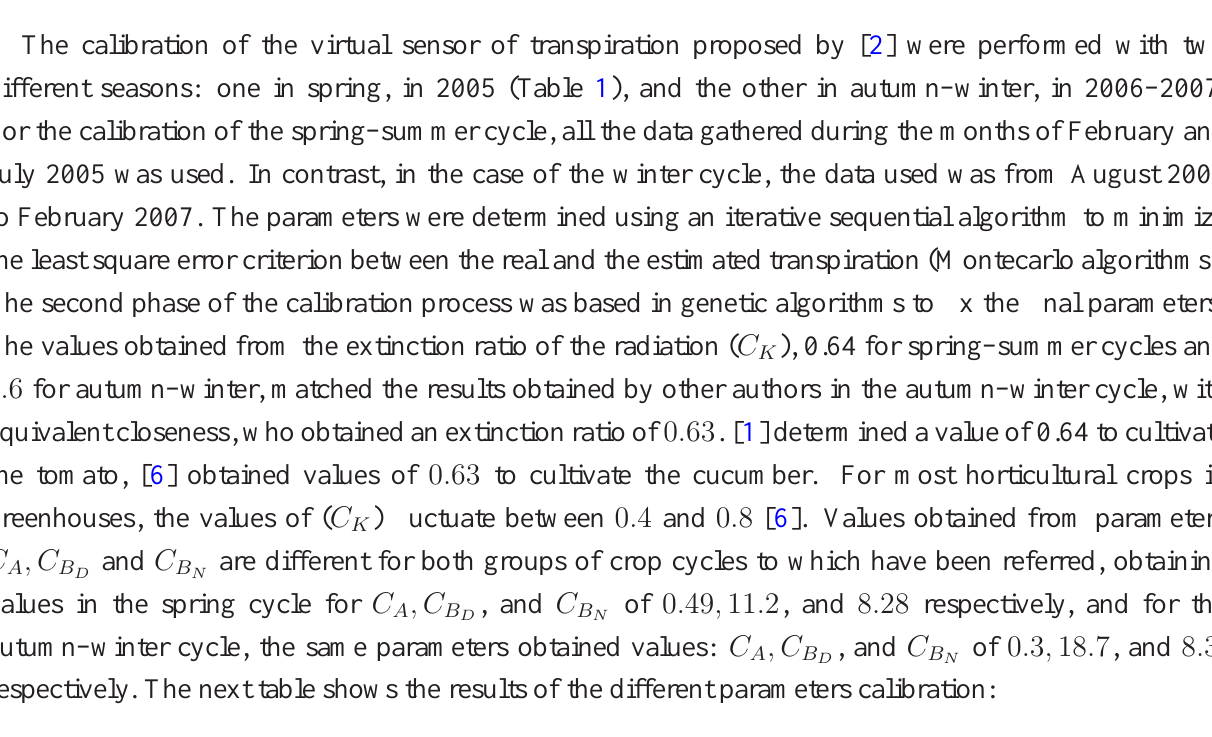
Table 1. Results of the calibration in spring–summer and autumn–winter